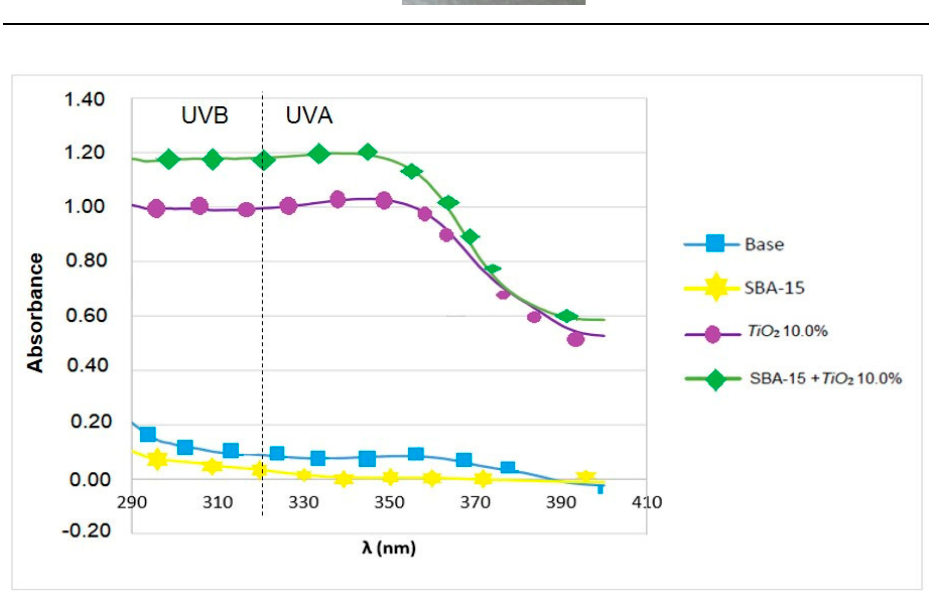
Figure 1. Absorption curves in the UV range of the lipstick base, SBA-15, TiO 2 and SBA-15 + TiO 2 samples generated by the UV-2000 software. Table 3. Values of in vitro sun protection factor (SPF) and critical wavelength ( λ crit , nm) of the samples (lipstick base, SBA ‐ 15, TiO 2 , and SBA ‐ 15 + TiO 2 ).